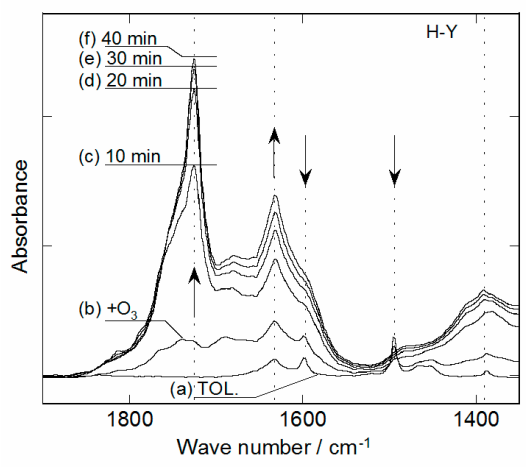
Figure 7. Infrared spectra for toluene decomposition on H-Y(1): ( a ) toluene adsorbed onto H-Y; after addition of O 3 for ( b ) 0, ( c ) 10, ( d ) 20, ( e ) 30, and ( f ) 40